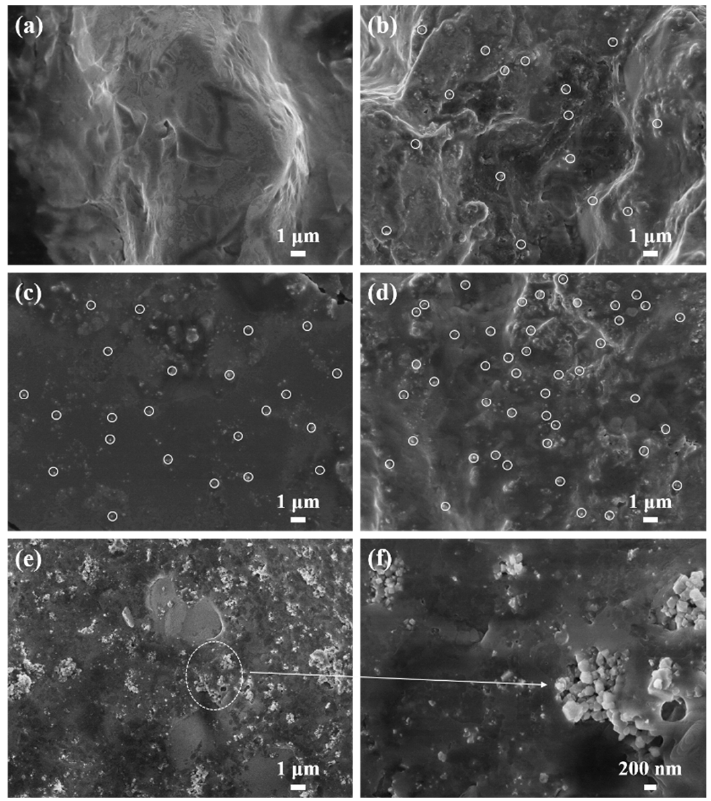
Figure 4. SEM micrographs of ( a ) sample S 0 , ( b ) sample S 2 , ( c ) sample S 4 , ( d ) sample S 6 , and ( e , f ) sample S 7 .